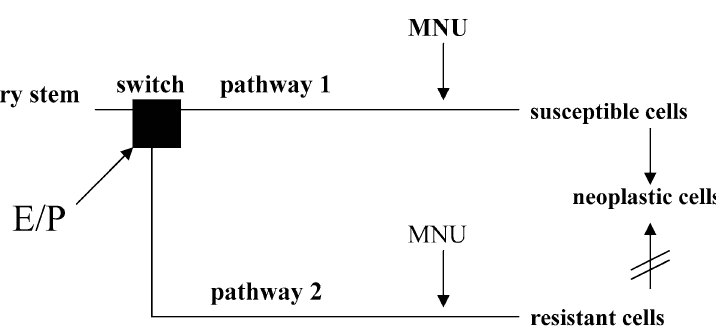
Fig. 1. Scheme illustrating proposed estrogen plus progesterone (E/P) switch (arrow). In pathway 1, post-pubescent virgin females exposed to MNU have high susceptibility mammary tumors, in pathway 2, Parous females, or those exposed to elevated E + P are generally resistant to MNU exposure.